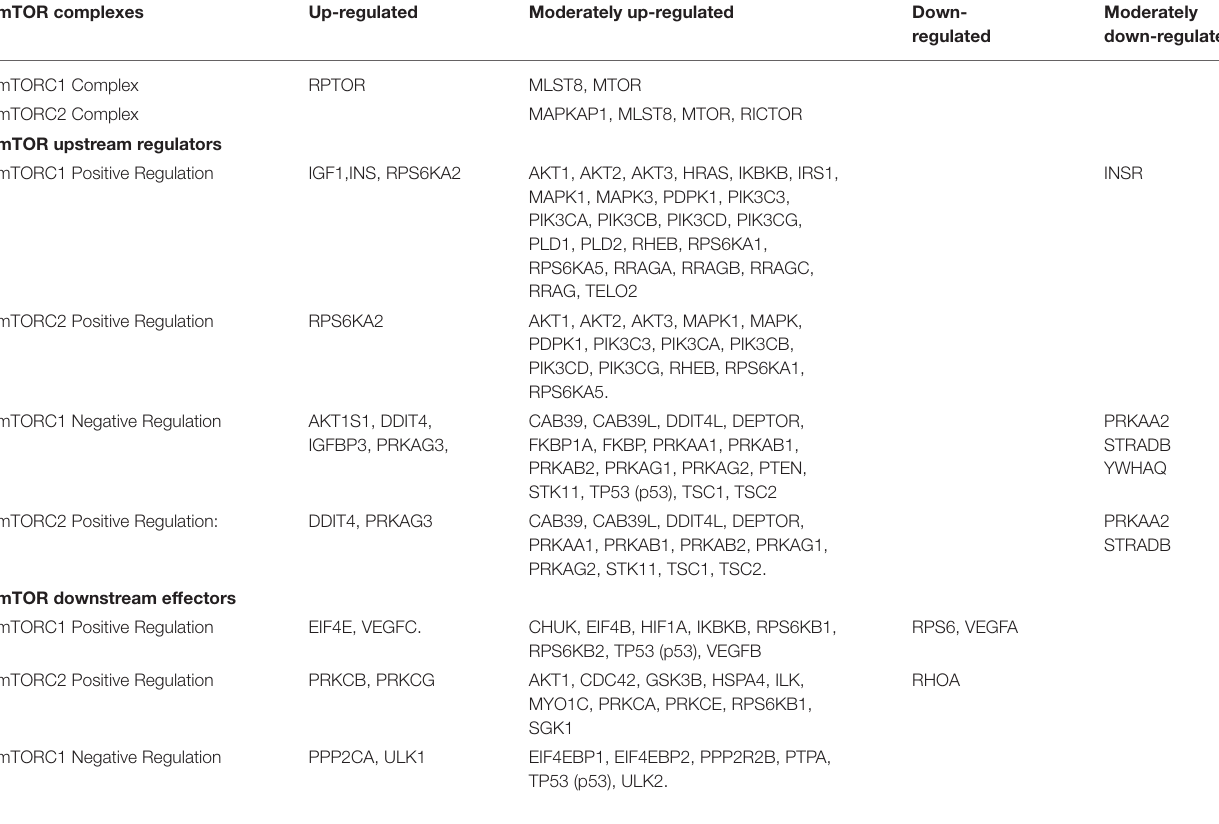
Moderately regulated down-regulated MAPKAP1, MLST8, MTOR,